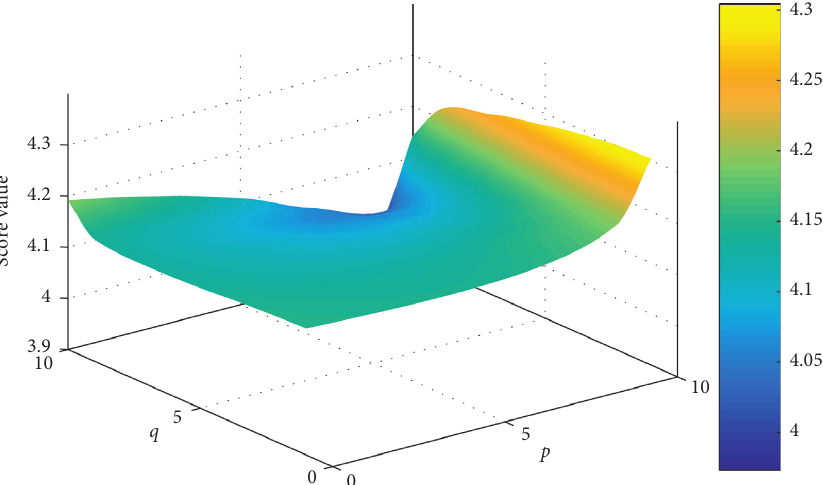
Figure 5: Scores of A